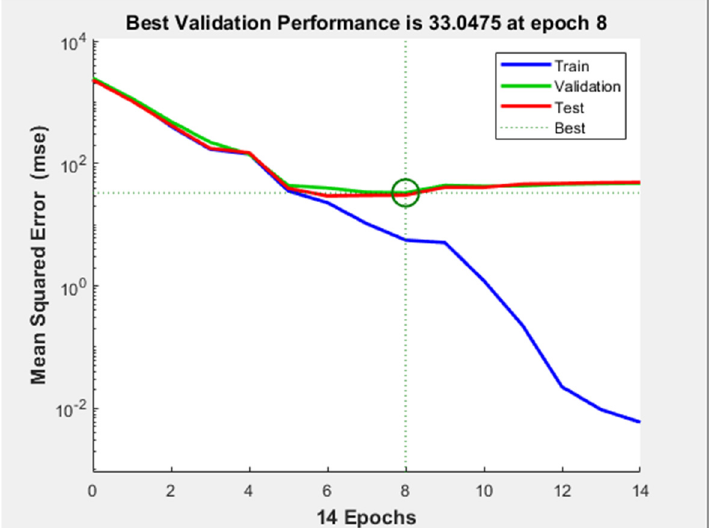
Figure 12. Performance plot of neural network with 10 hidden-layers and 20 neurons on each hidden-layer.